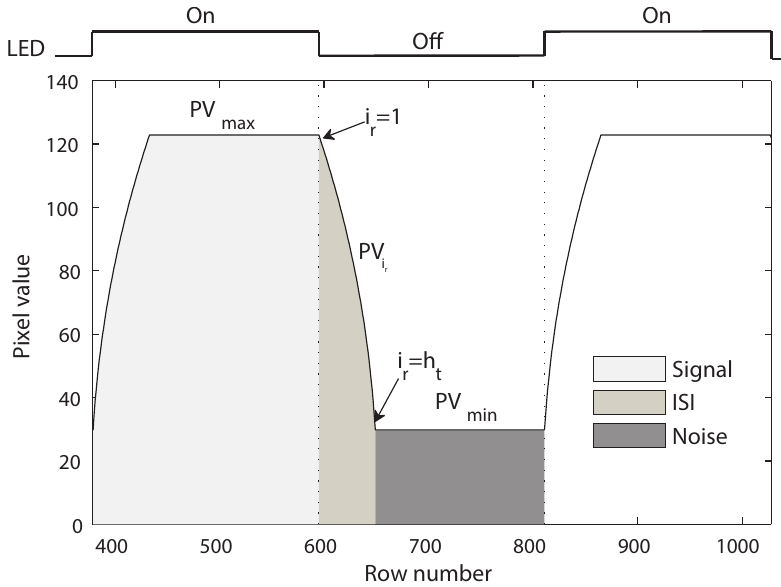
Figure 8. Signal to interference plus noise